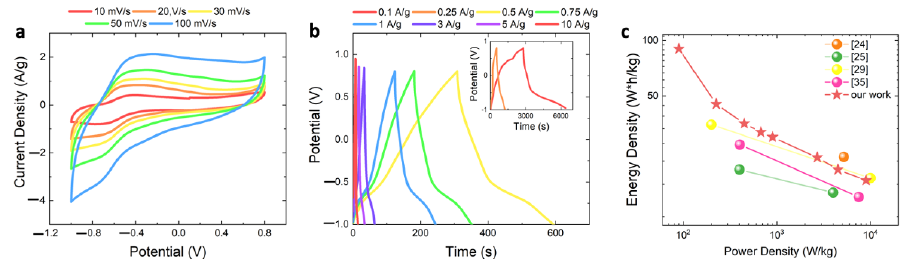
Figure 6. ( a ) CV curves at different scan rates of the ASC realized by using GP as anode and NF WO 3 _ann70 paste electrode (schematic illustration in the inset); ( b ) GCD of ASC in the potential range between − 1 to 0.8 V. The inset shows a magnification of GCD curves at higher current density; ( c ) Ragone plot obtained from the as tested WO 3 -based ASC (red stars) compared to those reported in the literature for WO 3 -based ASC. Potential is measured versus SCE.